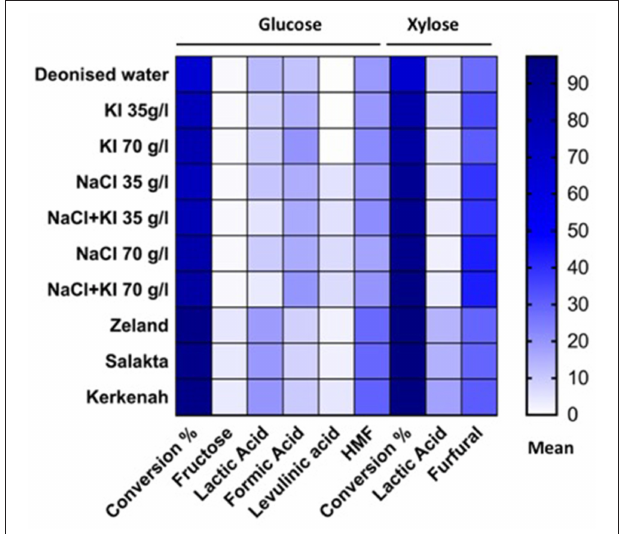
FIGURE 7 | The effect of inorganic salts and seawater on D-xylose and D-glucose conversion.